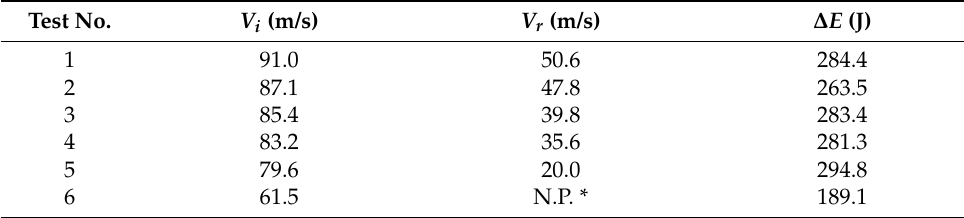
Table 2. Results of the ballistic test on 500 × 500 mm panels.